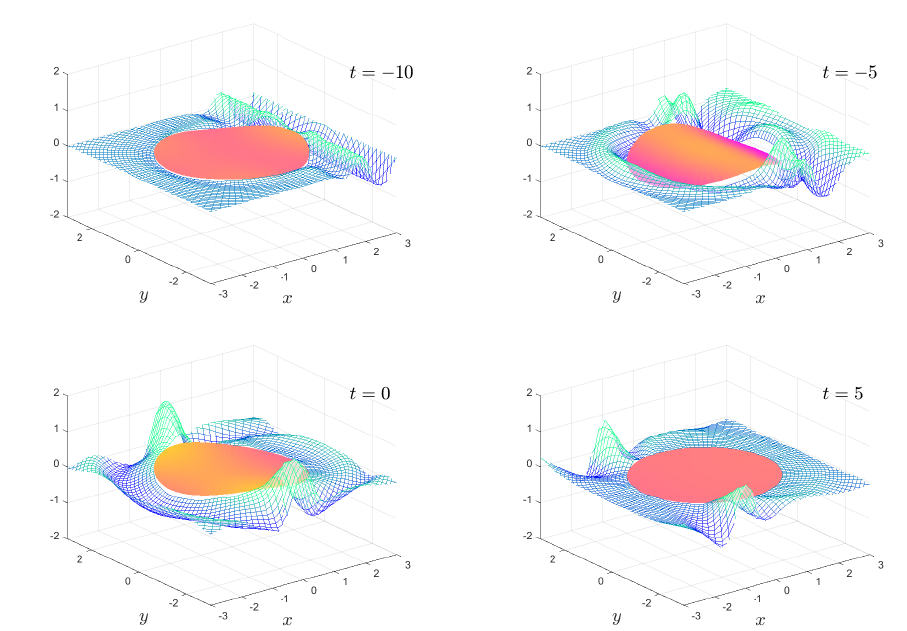
Figure 3. As in Figure 2, except β = 1 × 10 − 2 . The full animation can be found in movie 2.